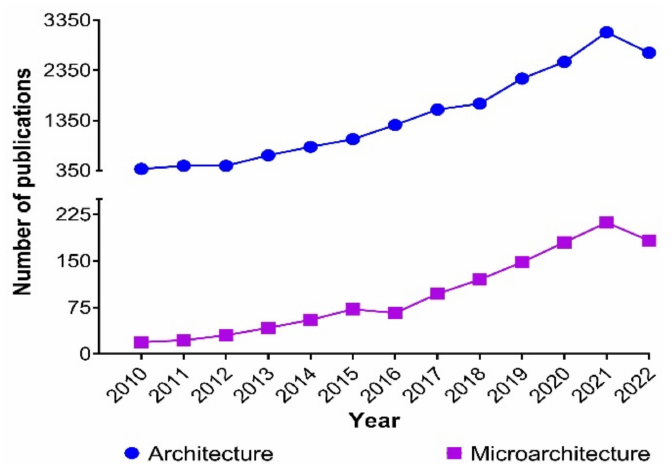
Figure 1. Publications per year from 2010 to June 2022 in the SCOPUS ® database (accessed on 21 June 2022), including review articles, research articles, book chapters, conference abstracts, book reviews, conference papers, editorials, mini-reviews, and short communications in all areas of knowledge, using the keywords “hydrogel architecture” ( n = 18,751) and “hydrogel microarchitecture” ( n =